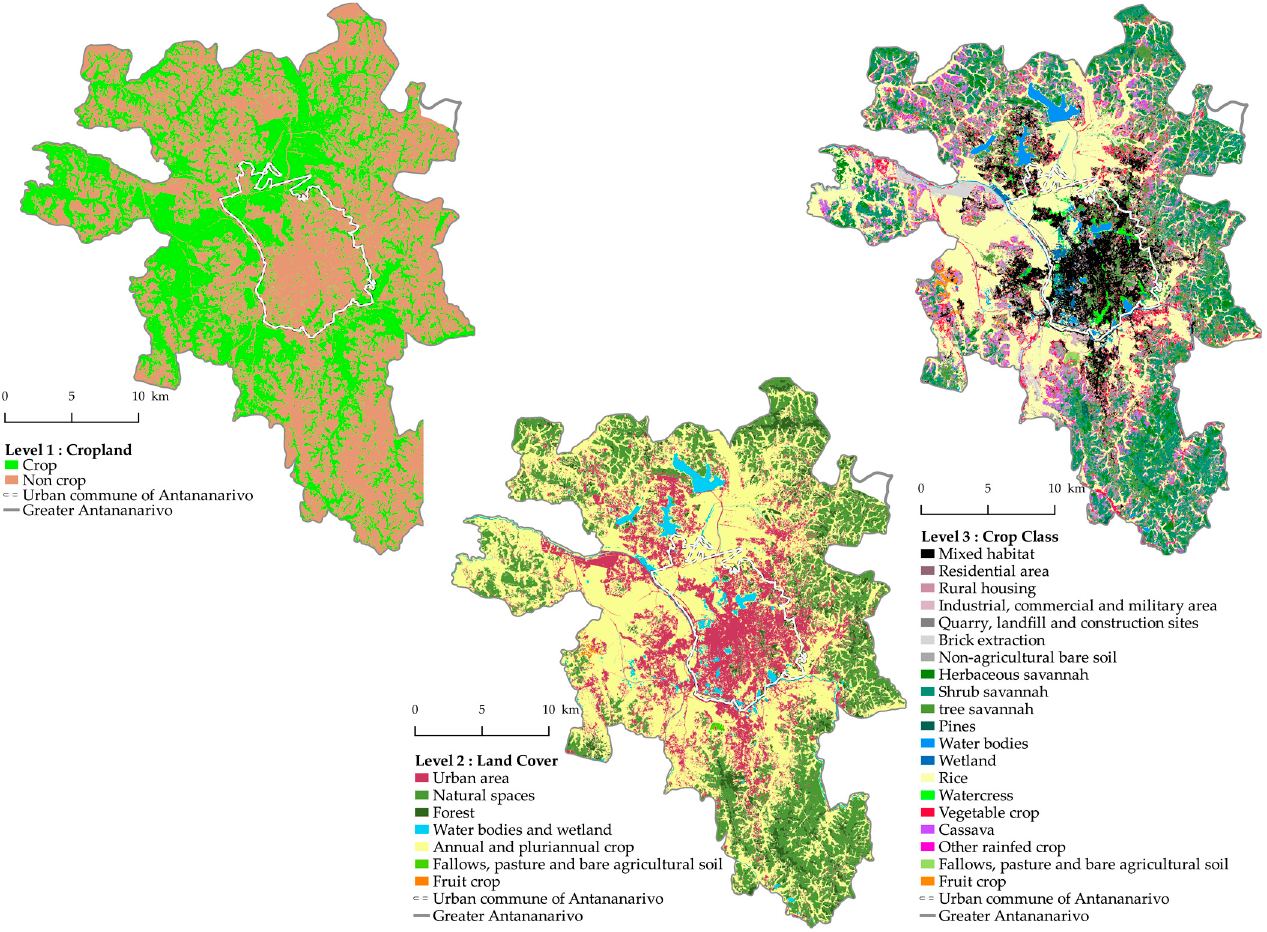
Figure 5. Land use maps of Greater Antananarivo with a zoom on the city center at two different nomenclature levels (level 1—cropland, level 2—land cover, level 3—crop class).